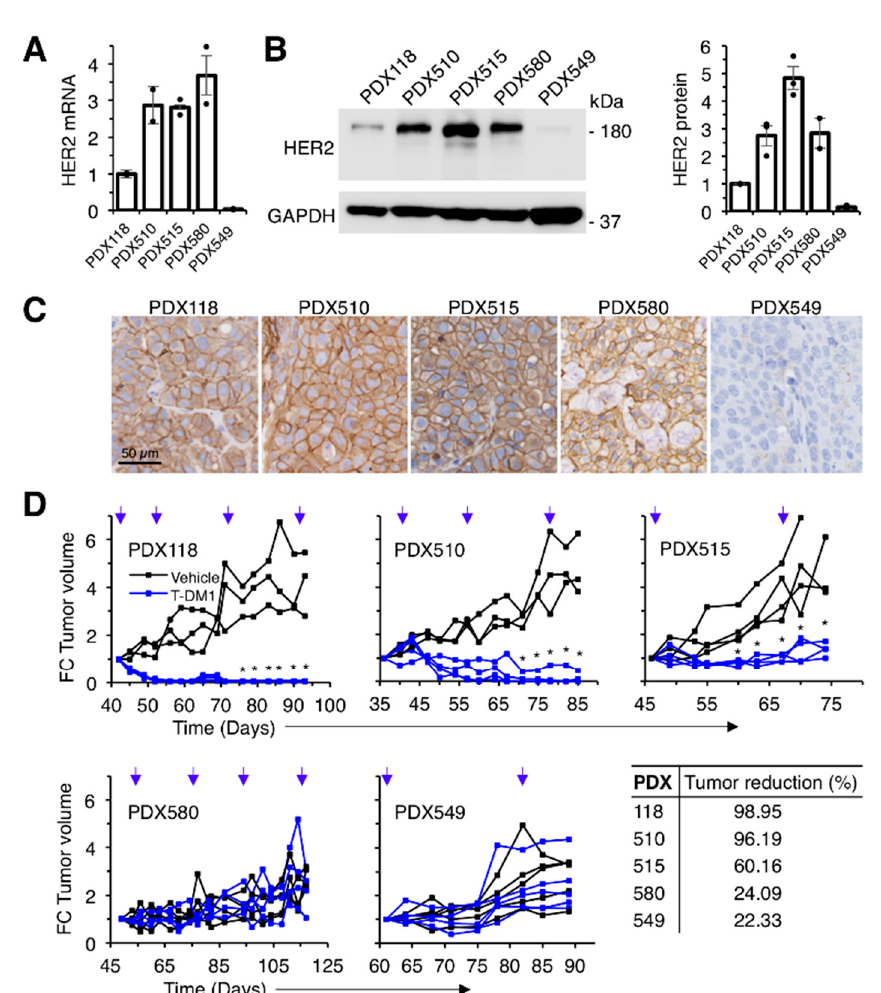
Figure 1. E ff ect of T-DM1 on the growth of breast cancer PDXs with di ff erent HER2 expression levels. ( A) Relative HER2 mRNA expression was determined by RT-PCR in a collection of breast cancer PDXs. Data were normalized to GAPDH mRNA. Averages and standard deviation of two independent determinations are represented; ( B ) Lysates from the same PDXs were analyzed by Western blot with the indicated antibodies (left panel) and densitometrical quantification was performed (right panel). Quantitative results are expressed as averages ± standard deviations of three independent experiments; ( C ) Immunohistochemical analysis of the expression of HER2 in the same PDXs; ( D ) NOD / SCID mice carrying the indicated PDXs were treated with vehicle or T-DM1 as indicated (blue arrows). Tumor volume was determined and expressed as fold-change relative to the initiation of treatment. Tumor reduction was calculated at the end of the experiment as the percentage of the average tumor volumes of the tumors treated with T-DM1 relative to tumors treated with vehicle. * p < 0.05, two-tailed Student t test.